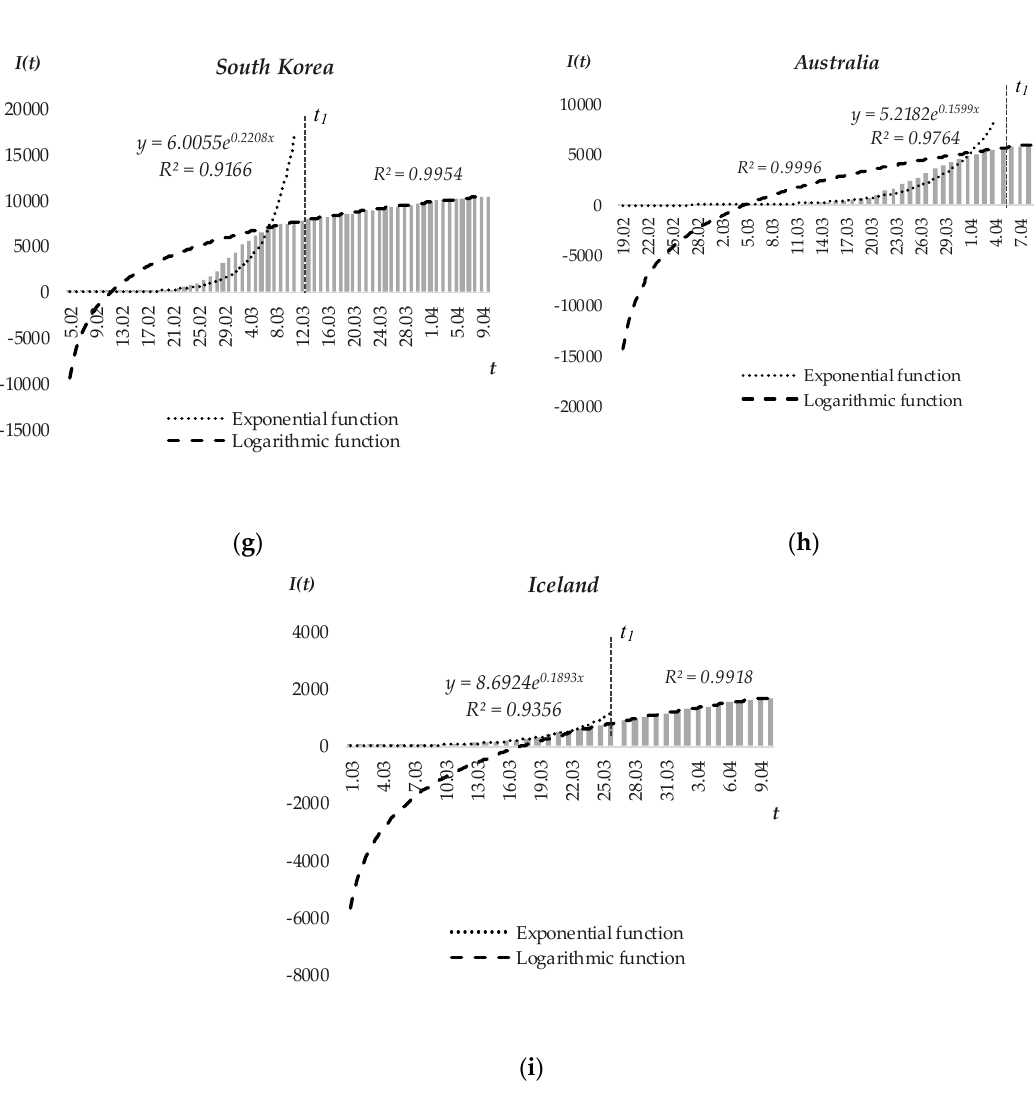
Figure 1. Growth stages of COVID-19 infection worldwide: ( a ) exponential stage of disease growth in China; ( b ) logarithmic stage of disease growth in China; ( c ) dynamics of the number of diseases in Spain; ( d ) dynamics of the number of diseases in Italy; ( e ) dynamics of the number of diseases in Germany; ( f ) dynamics of the number of diseases in Austria; ( g ) dynamics of the number of diseases in South Korea; ( h ) dynamics of the number of diseases in Australia; ( i ) dynamics of the number of diseases in Iceland.